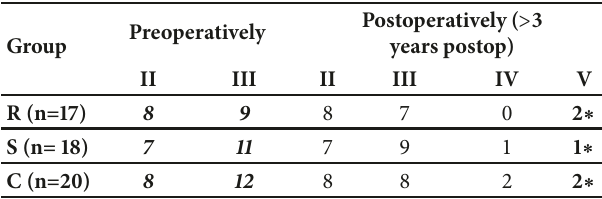
Table 4: Pfirrmann degeneration grade in MRI in the 1 st supradja- cent segment preoperatively till the final